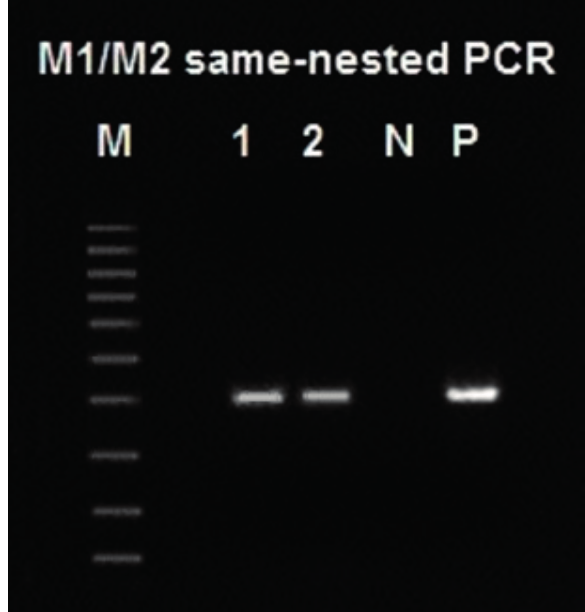
Figure 1. Agarose gel electrophoresis showing the M1/M2 primer-defined same-nested PCR amplicon. M = molecular ruler, 100–1000 bp; Lanes 1 and 2 = B. miyamotoi 16S rDNA M1/M2-defined PCR amplicon, in duplicate; N = negative water control; P = ATCC 53210 B. burgdorferi positive control.